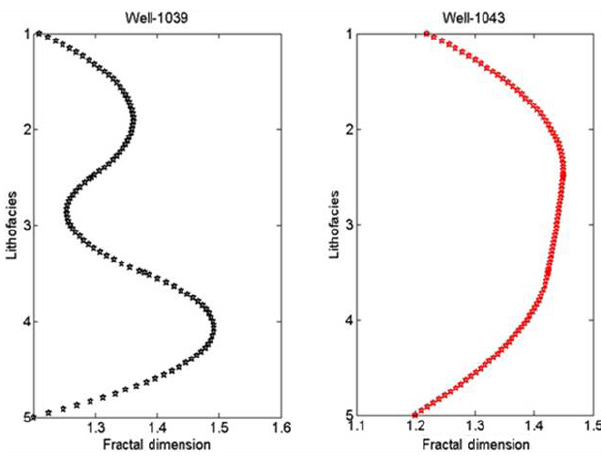
Figure 11. FD values of both well sites 1039 and 1043.